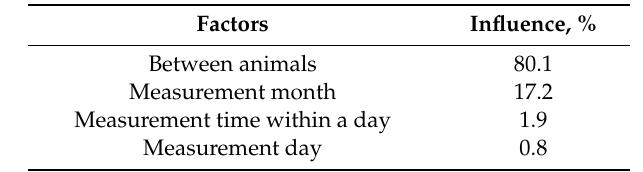
Table 4. Contribution of variance components a ff ecting BW measurement deviation 1